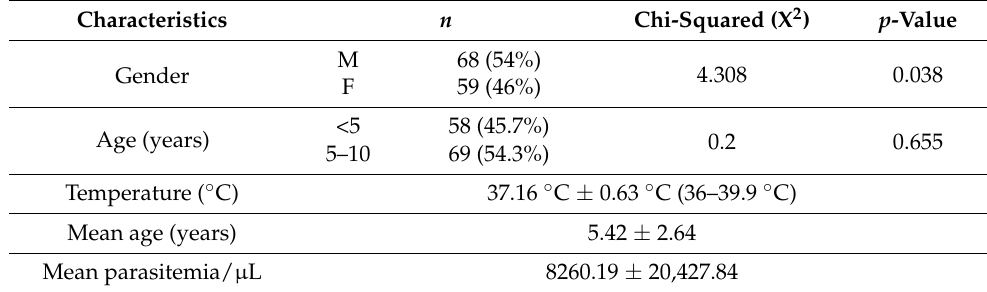
Table 2. Characteristics of the study population. Characteristics